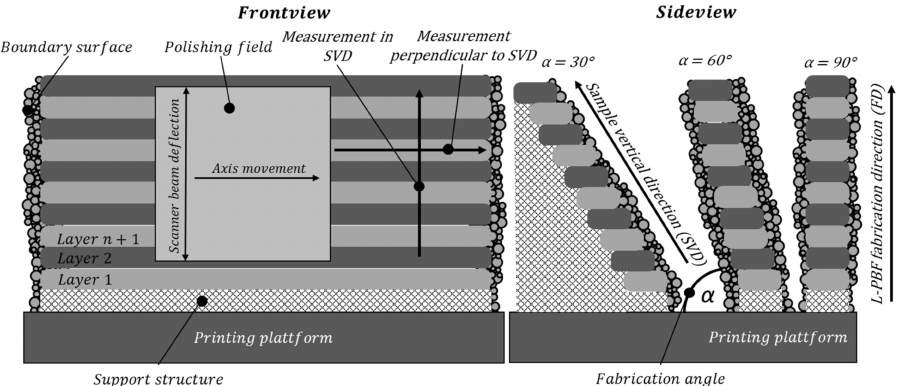
Figure 4. Definition of the L-PBF fabrication, polishing and measurement directions on the AM